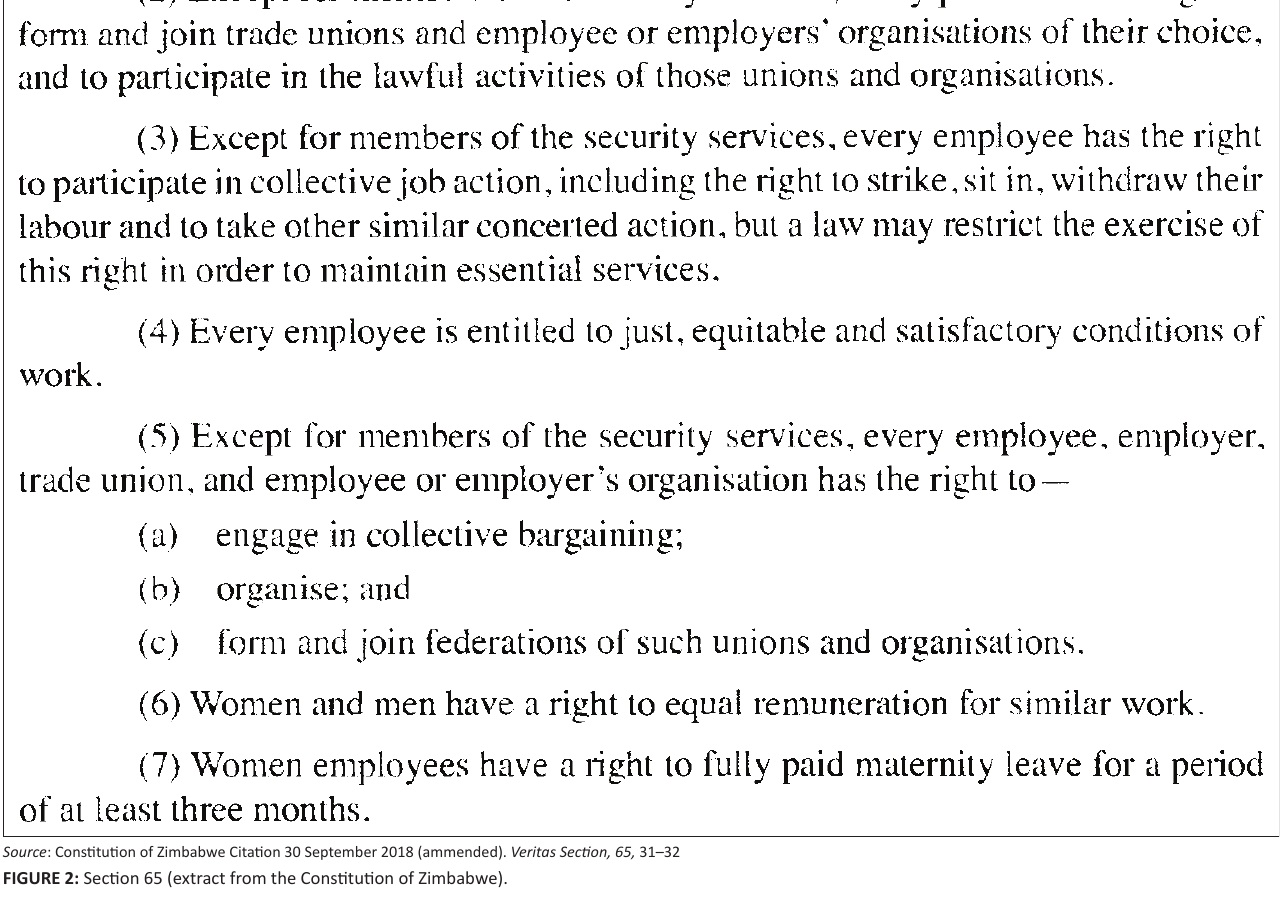
FIGURE 2: Section 65 (extract from the Constitution of